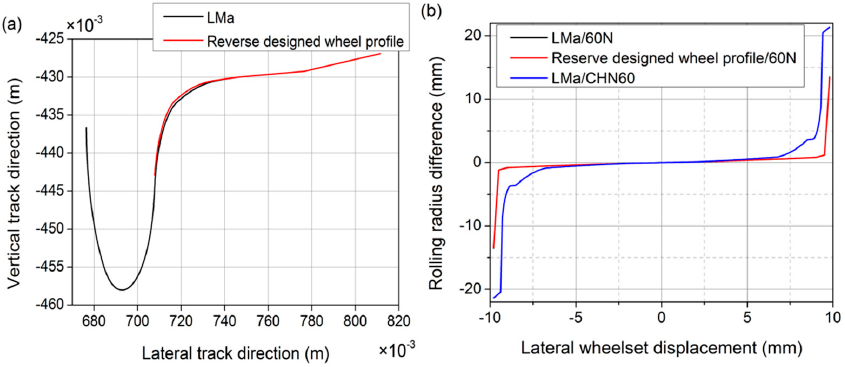
Figure 15. Wheel profile and rolling radius difference. ( a ) Wheel profile; ( b ) Rolling radius difference.